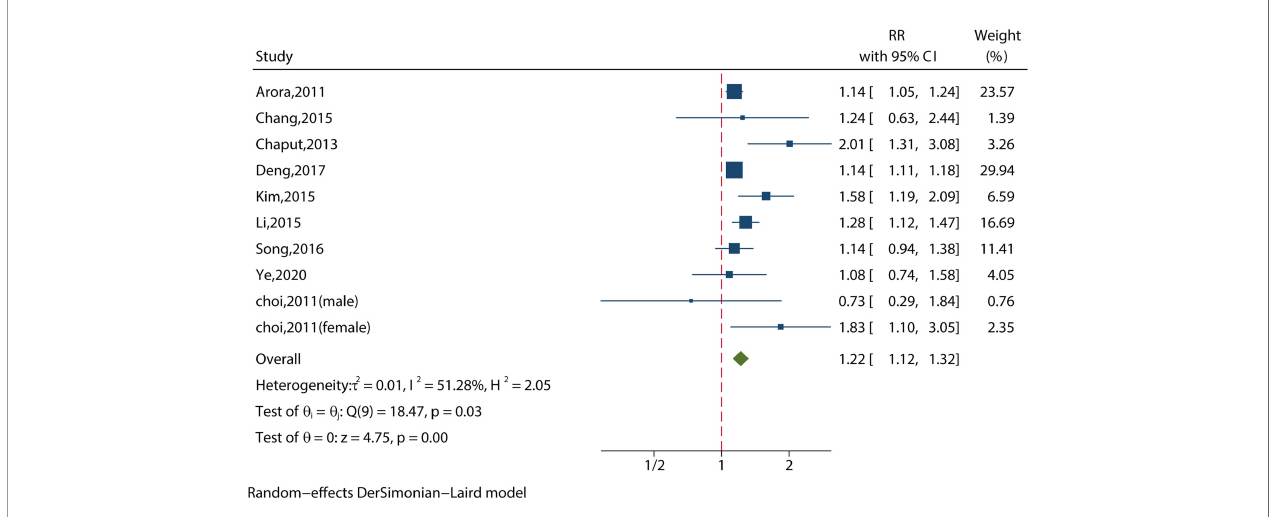
FIGURE 4 | Meta-analysis of the association between short sleep and risk of metabolic syndrome from crude models or least-adjusted